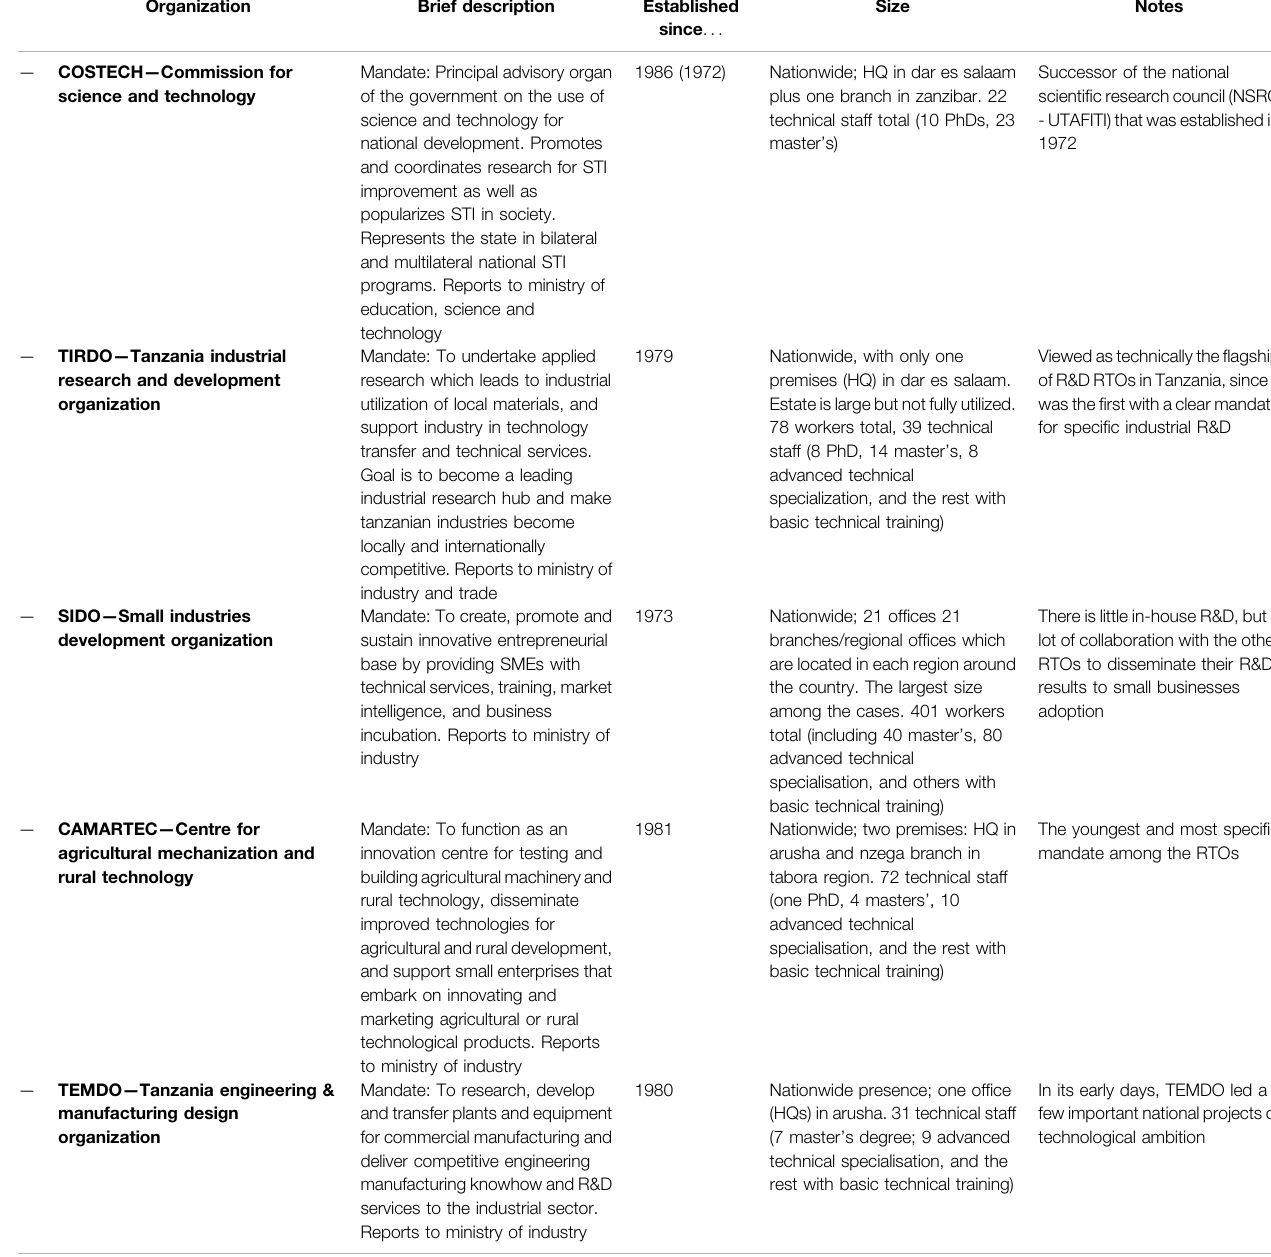
TABLE 2 | Research Participant Organizations (RTO case studies) a .